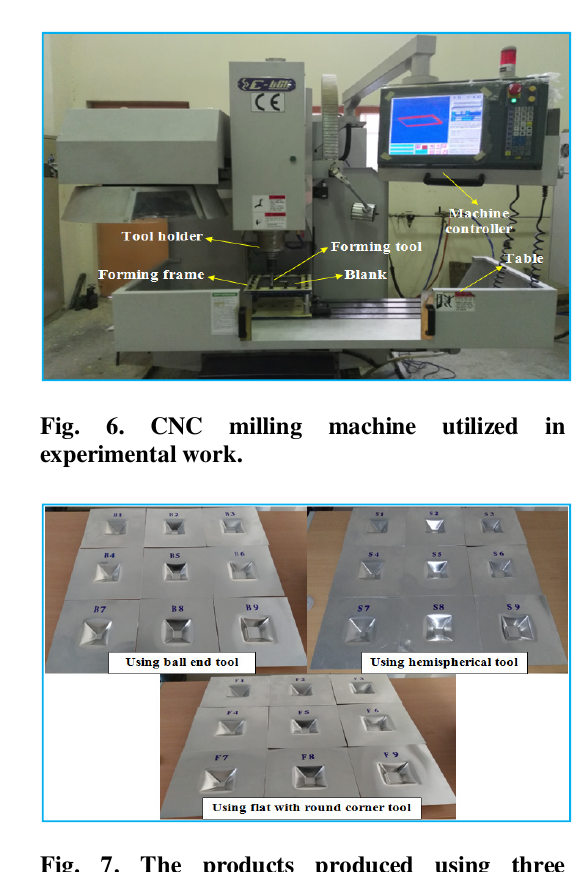
Fig. 7. The products produced using three different geometries of